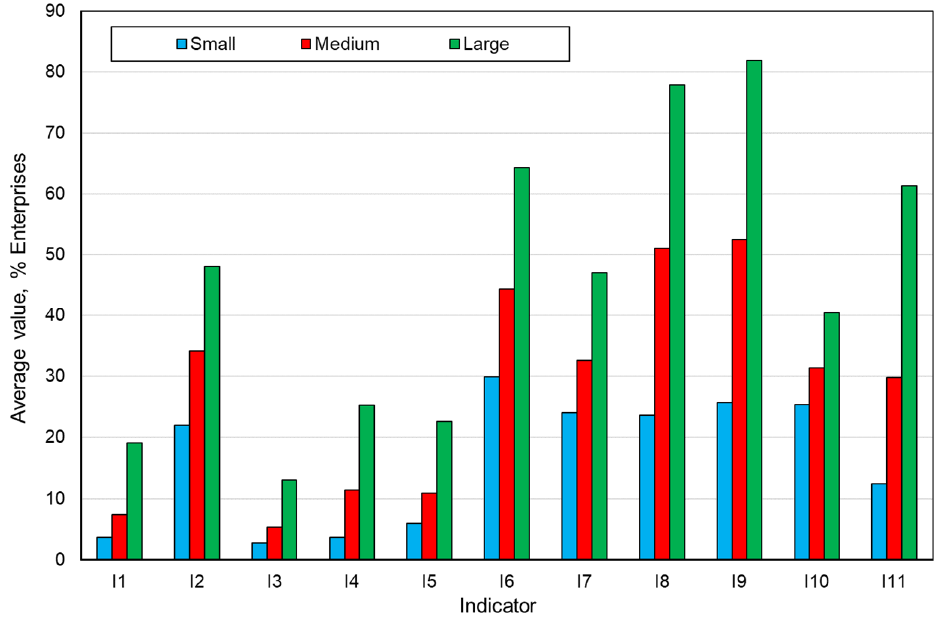
Figure 5. Average use of Industry 4.0 technologies, infrastructure and training in different groups of enterprises in the CEE countries.